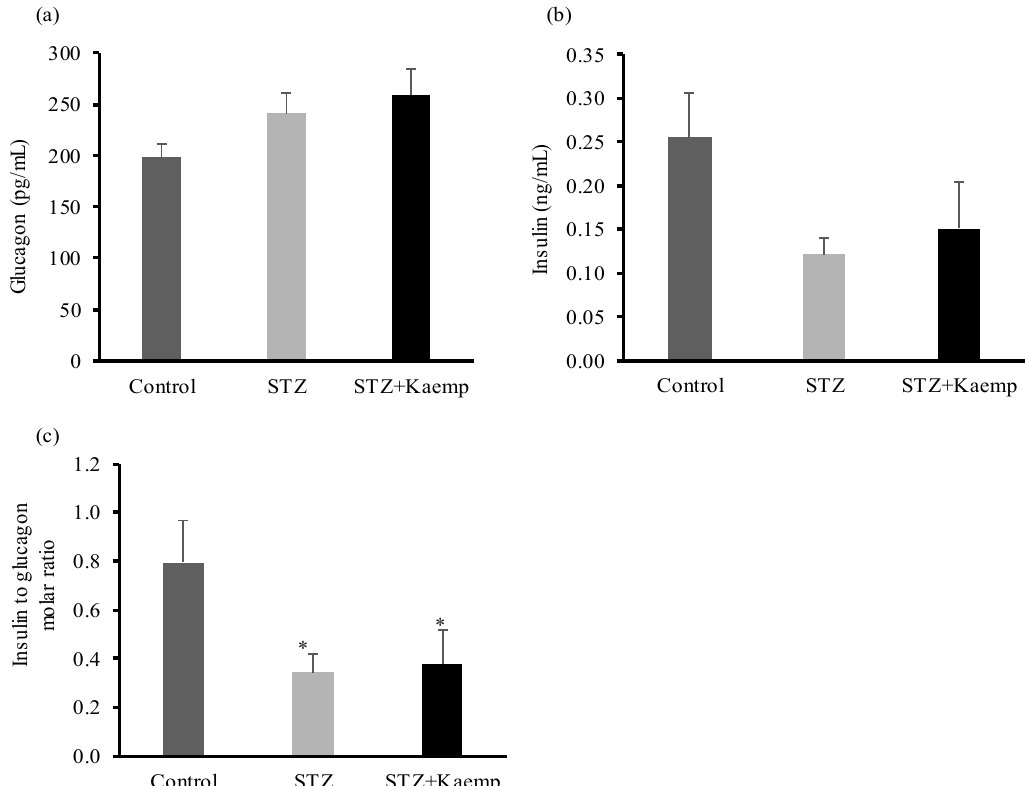
Figure 5. Kaempferol had no effect on the concentrations of circulating plasma insulin or glucagon levels. After 12 weeks of treatment with kaempferol, ( a ) glucagon, and ( b ) insulin levels in the blood were measured using ELISA kits, and ( c ) their molar ratio was calculated. Data are shown as Mean ± SEM ( n = 8–9). * p < 0.05 vs. Control nondiabetic mice. Control: nondiabetic mice; STZ: STZ-induced diabetic mice; STZ + Kaemp: STZ-induced diabetic mice treated with kaempferol (50 mg/kg BW).